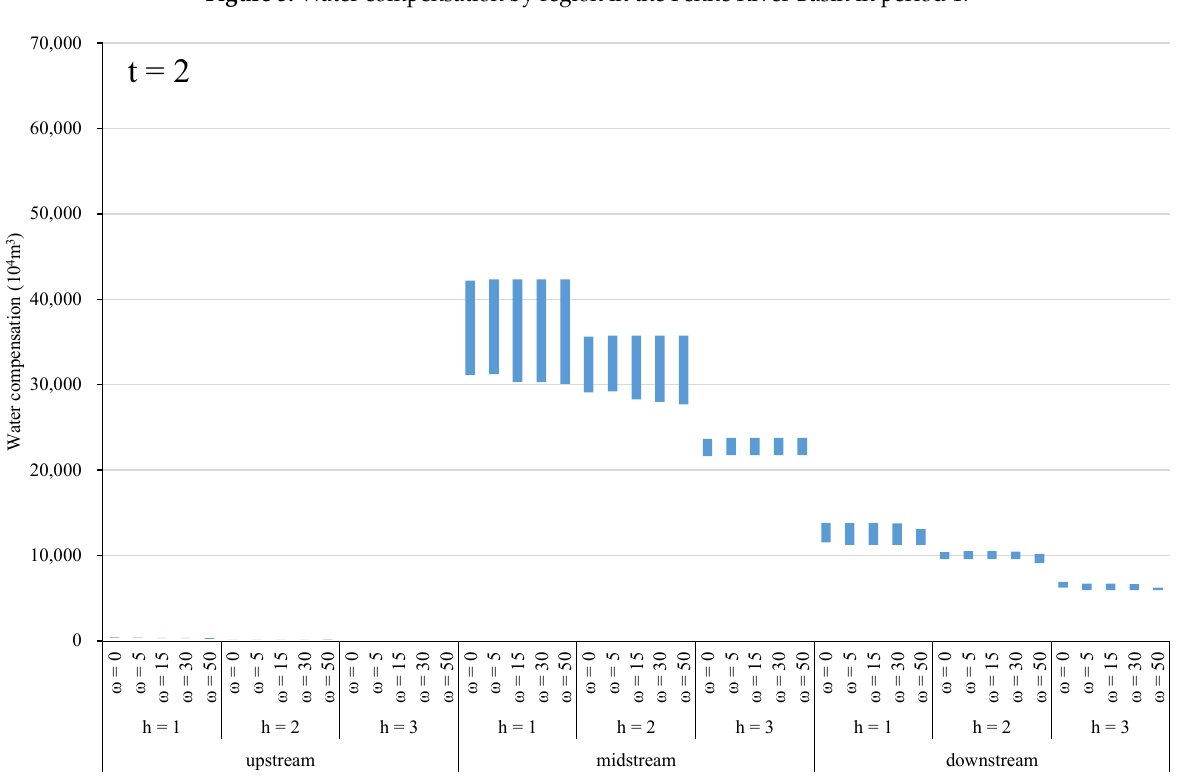
Figure 6. Water compensation by region in the Fenhe River Basin in period 2.